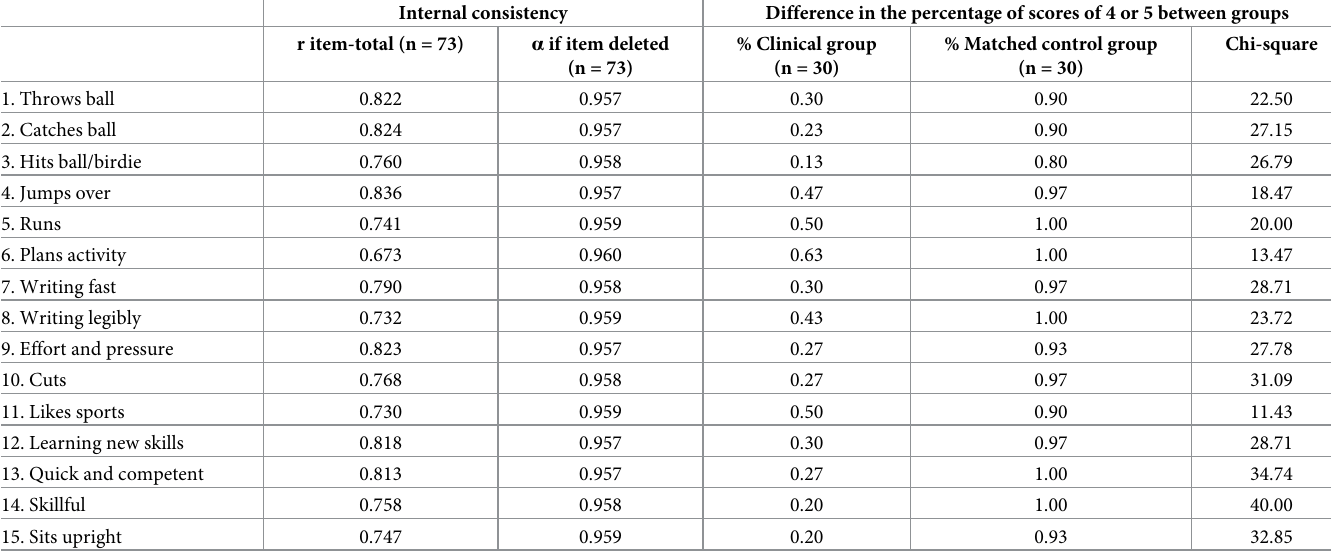
Table 2. Results of the internal consistency analysis and differences in percentage of scores 4 and 5 between the clinical and the control group.